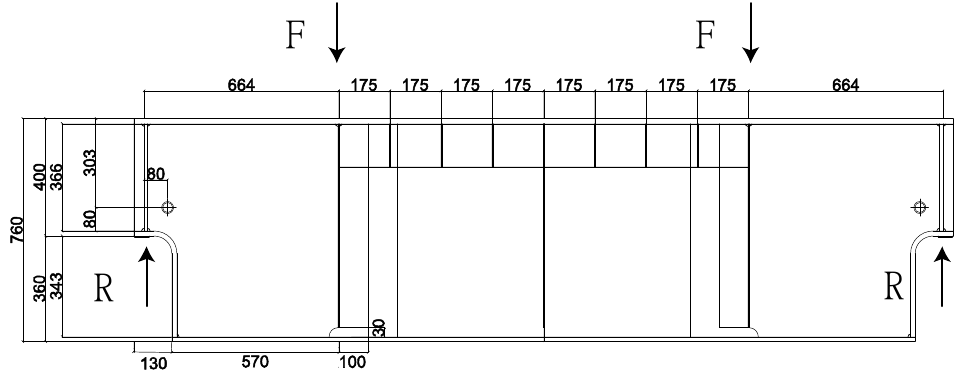
Figure 6. Dimensions of the variable-section support specimens with R-plates and three-web plates.